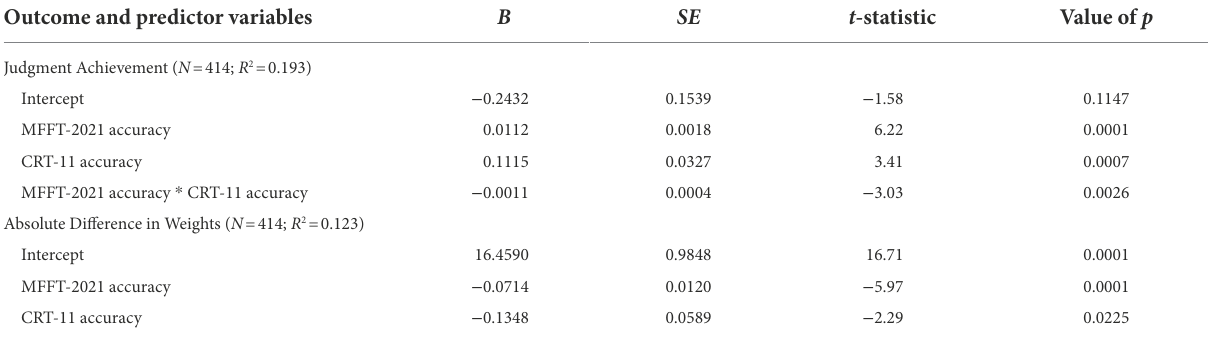
TABLE 5 Study 1 Regression analysis of configural information